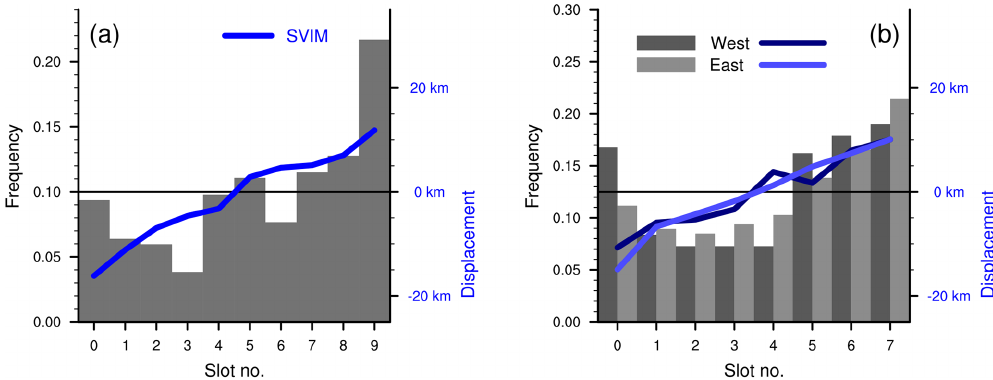
Figure 7. Rank histogram for model results for the local ice edge displacement corresponding to the position of the maximum observed displacement. (a) Sets of nine alternative model displacements were derived for each of 235d with 24h displacements results. The nine displacement values were ordered from lowest to highest, and the local displacement was given a rank from the slot in which this value belonged; see the text for details. The blue curve shows the average local model displacement distances for results belonging to each of the ranks, with negative numbers corresponding to local sea ice retreat in the model results. The average maximum observed displacement is 39km. (b) Results obtained for a subdivision as indicated by the red line in Fig. 4. Here, sets of seven alternative displacements results were derived for each subdomain. Then, results were available for 179 and 224d for the western and eastern subdomains, respectively. The average maximum observed displacements are 36km in both subdomains. The use of gray shading and line colors for the subdomains are indicated by the inset label. The y axes in (a) and (b) have been specified so that the black horizontal 0-axis lines for the right-side axes correspond to the frequency level of a flat distribution of frequencies (left-side y